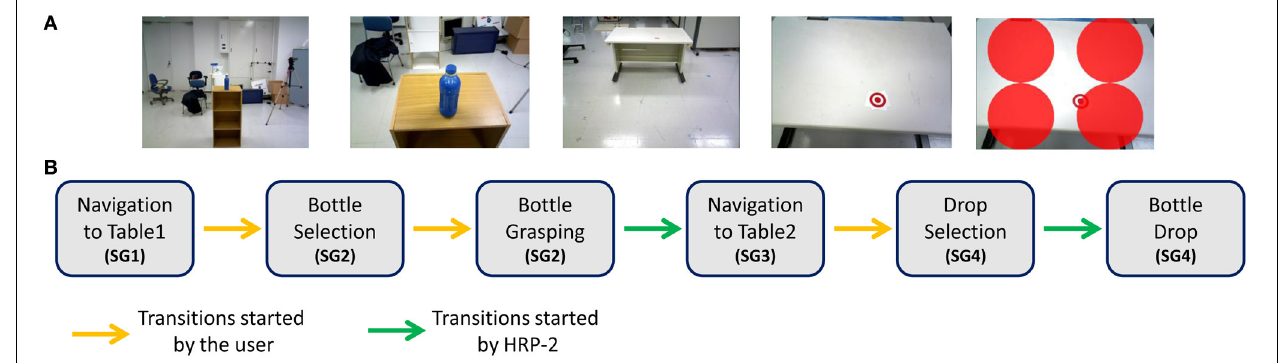
FIGURE 2 | (A) A sequence of images depicting the different sub-goals (SGs). (B) A state-flow diagram showing the Finite State Machine (FSM). Yellow arrows represent transitions initiated by the user while green arrows represent transitions initiated by the